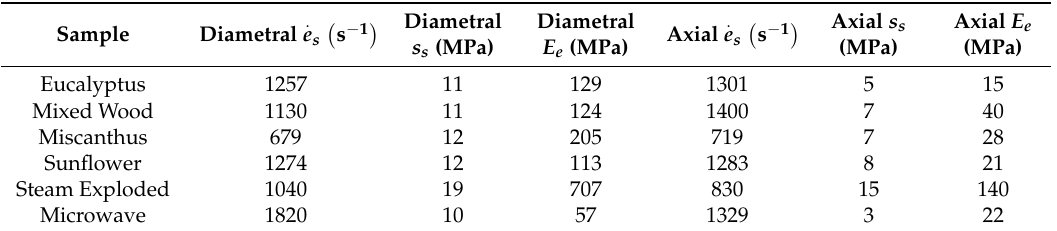
Table 3. Mean diametral and axial compressive Young’s modulus ( E e ), engineering stress ( s s ), and (cid:0) . (cid:1) e s engineering strain rates